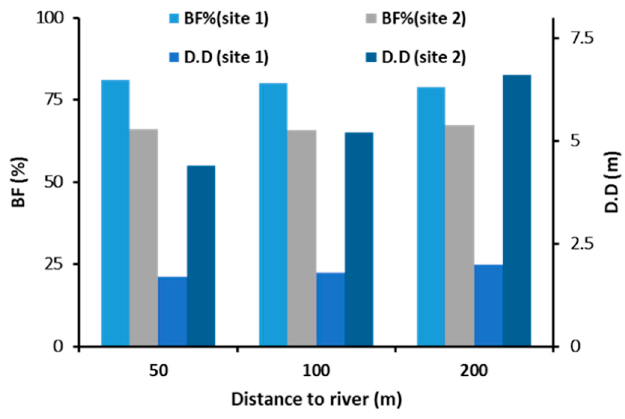
Figure 6. Impact of the distance between BF wells and surface water system on the bank filtrate share (BF %) and drawdown (D.D) at the two potential BF sites of Aswan City.